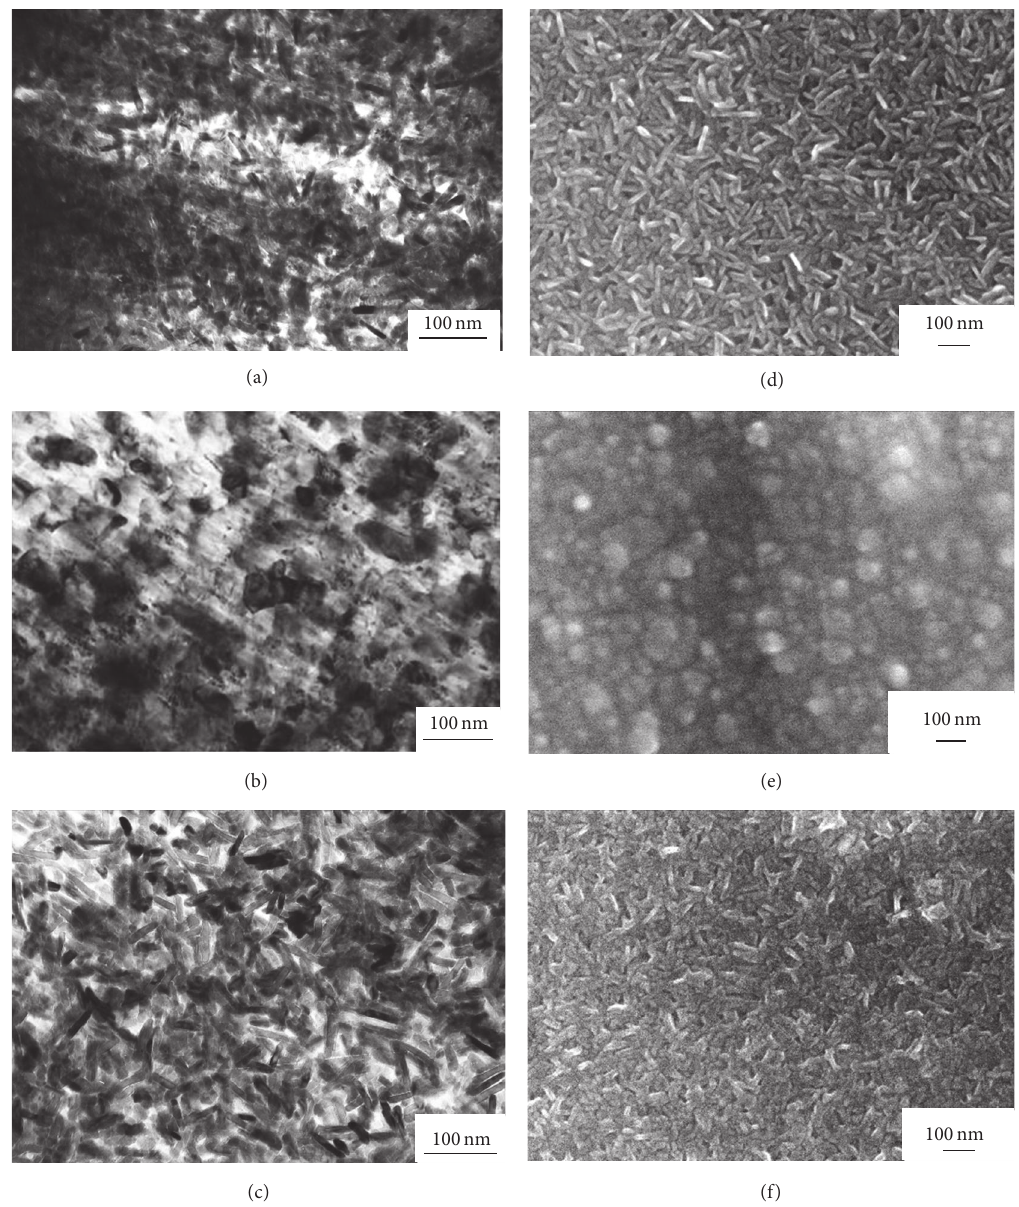
Figure 5: The structure of VN 𝑥 -H 𝑦 films: (a), (d) original state; (b), (e) hydrogen storage films, and (c), (f) annealed films.